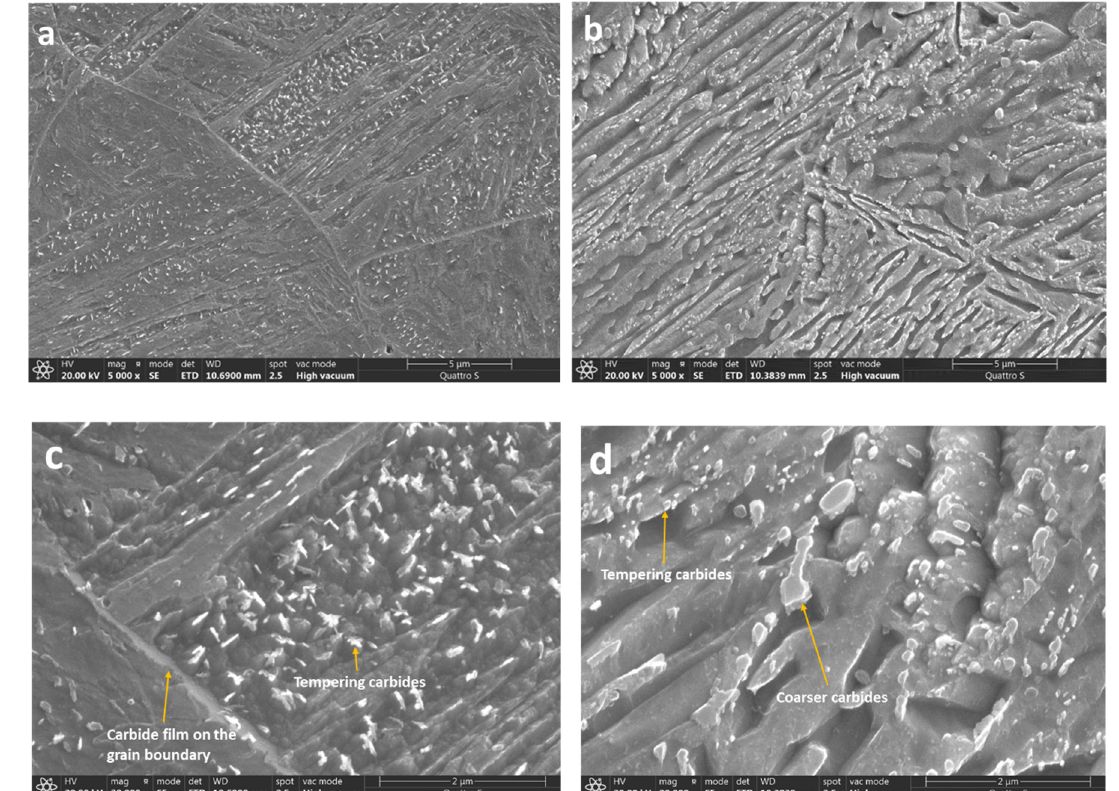
Figure 7. SEM images of ( a ), ( c ) Q + T (1000 + 450 °C) and ( b ), ( d ) Q + I + T (1000 + 760 + 450 °C) samples; SEI.